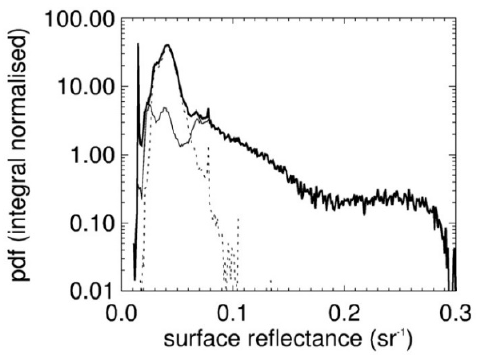
Figure 19. Probability distribution function of surface reflectence at 1.6 wavelength, computed using MODIS data over land (thin solid line) and GMAO winds over sea (thin dotted), for the whole year 2007[34].